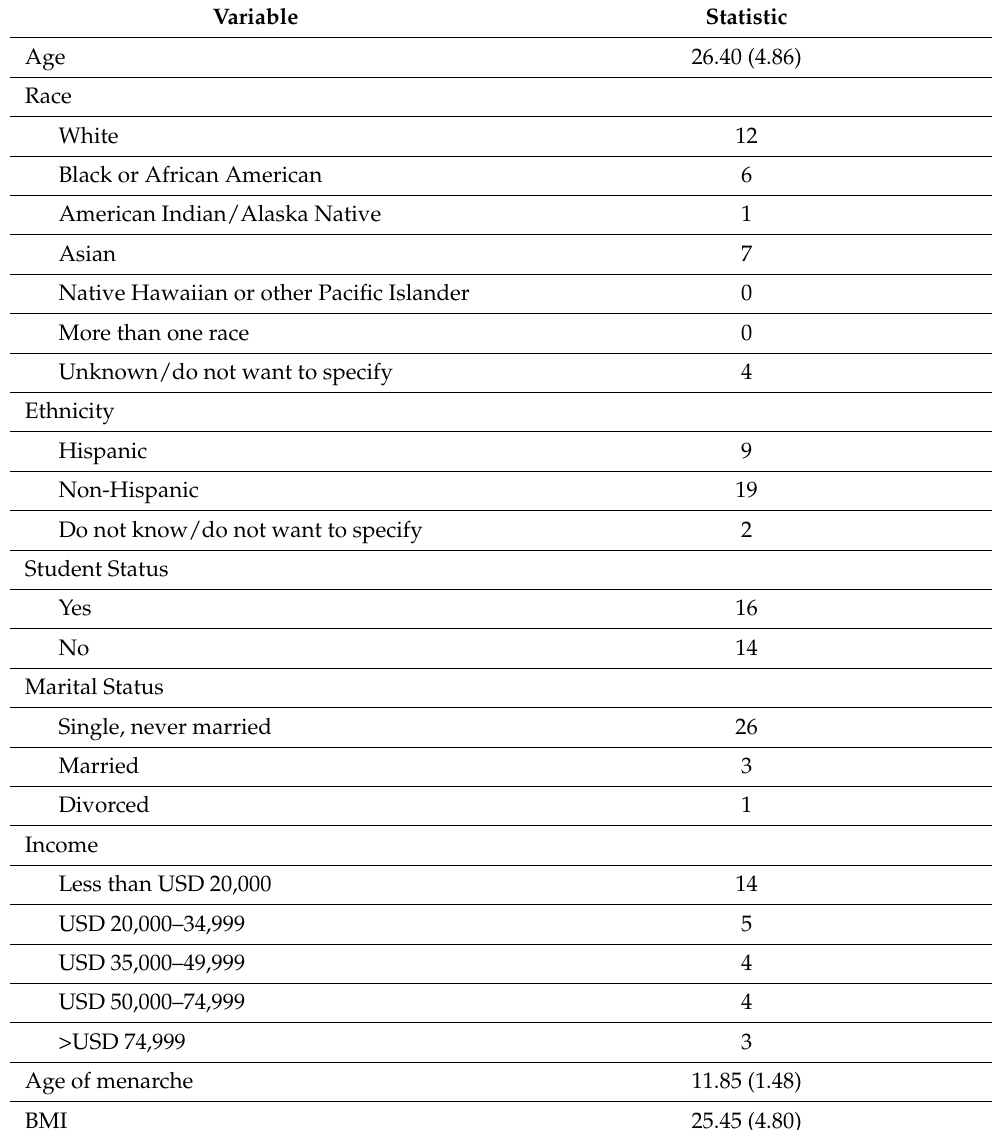
Table 1. Demographic and anthropomorphic characteristics of study participants with ovulatory cycle ( N = 30). Variable